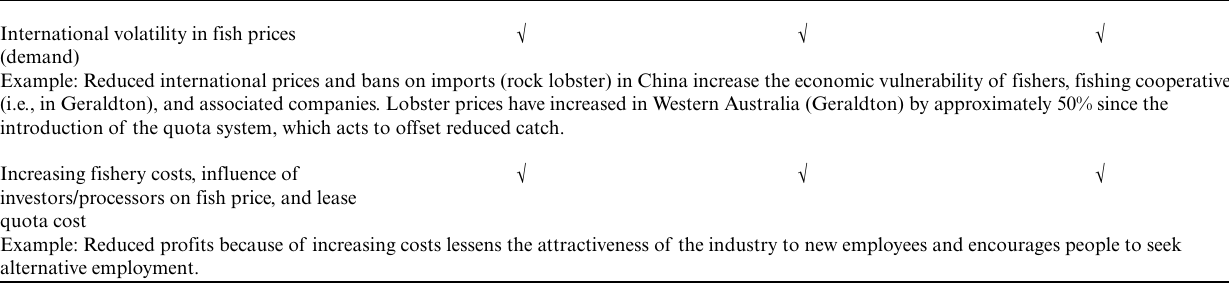
exposure were based on projected changes in ocean temperatures (identified using sea surface temperatures, SST), ocean acidification, rainfall, and storms and cyclones in the local area (Table 3). Climate drivers contributing to climate exposure were weighted for each case study. The weighting allocates a higher climate exposure to communities with large expected climate driven changes and a lower climate exposure score for communities with low-moderate expected climate driven changes. Weights were assigned based on reported changes to date (SST, acidification, storms, and cyclones) and future expectations